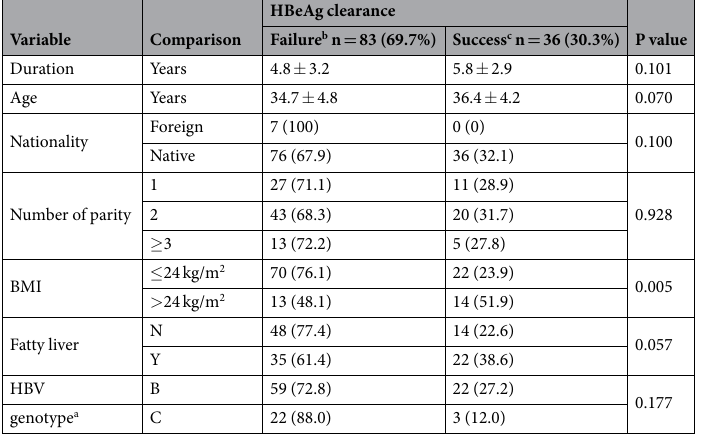
Table 4. Univariate analysis for successful HBeAg clearance and associated factors among parturients who were HBeAg-positive before delivery. a Subjects with detectable HBV DNA were included. b HBeAg( + ) or HBeAg( − ) but HBV DNA > 2000 IU/ml. c HBeAg( − ) and HBV DNA < 2000